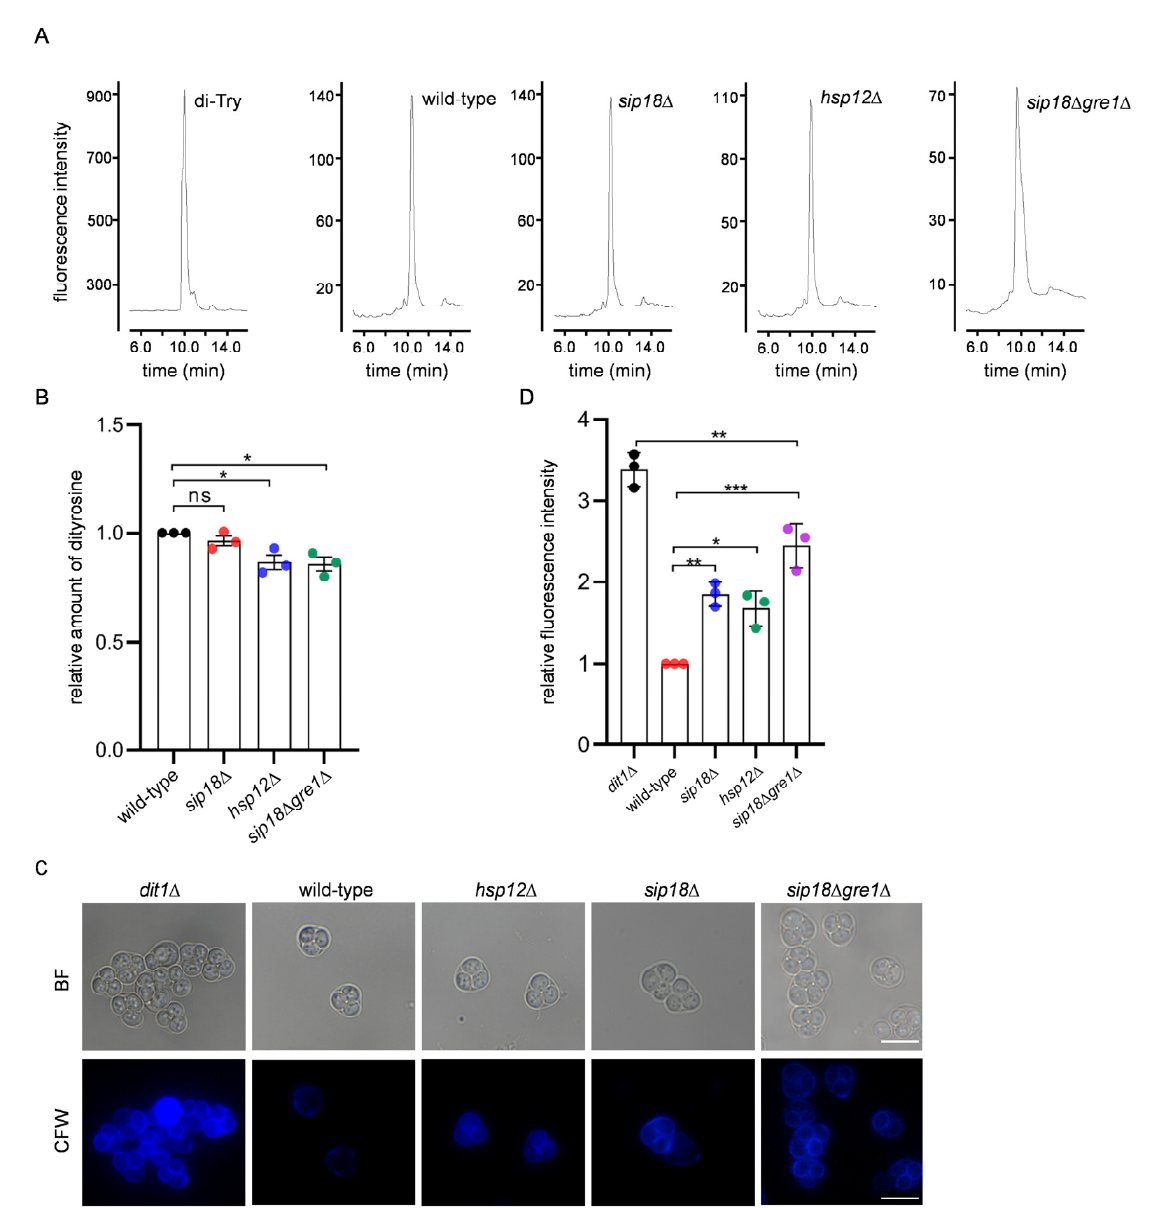
Figure 7. CFW staining assay of hydrophilin mutant spores. ( A ) Lysates of mutant spores were hydrolyzed with 6 N HCl and subjected to HPLC analysis. Synthesized dityrosine (di-Tyr) was assayed as a control. ( B ) The relative amount of dityrosine detected by HPLC described in ( A ). The dityrosine peak detected in the control sample was defined as 1. ( C ) The dit1 ∆ and wild-type sip18 ∆ , sip18 ∆ gre1 ∆ or hsp12 ∆ spores were stained with CFW and observed under fluorescence (CFW) or bright field (BF) microscopy. Scale bar, 5 μ m. ( D ) Quantification of the fluorescence intensities of CFW of the indicated spores. Data are presented as the mean ± SEM. Statistical significance was determined by two-tailed unpaired Student’s t -tests. n = 3. *, p < 0.05; **, p < 0.01; ***, p < 0.001; ns, not significant ( p ≥ 0.05).